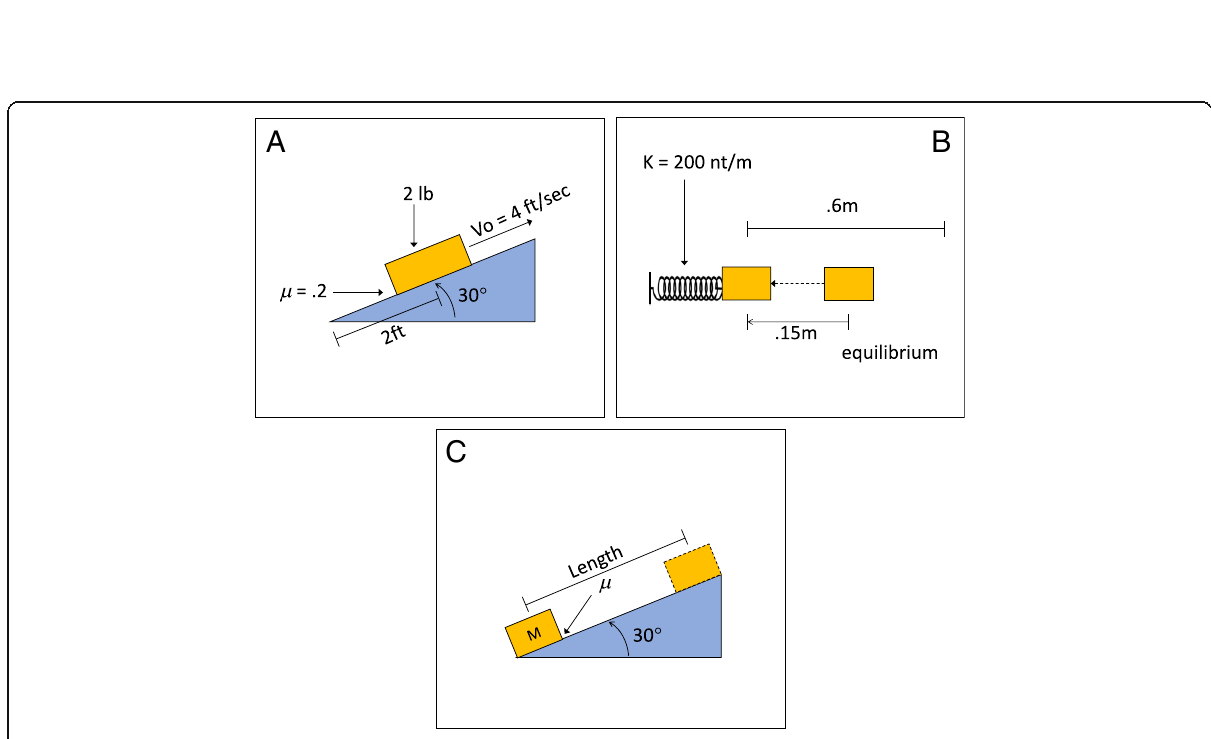
Fig. 5 Three examples of physics problems that would be categorized differently by novices and experts. The problems in ( a ) and ( c ) look similar on the surface, so novices would group them together into one category. Experts, however, will recognize that the problems in ( b ) and ( c ) both relate to the principle of energy conservation, and so will group those two problems into one category instead. Copyright note: the figure was produced by the authors, based on figures in Chi et al.